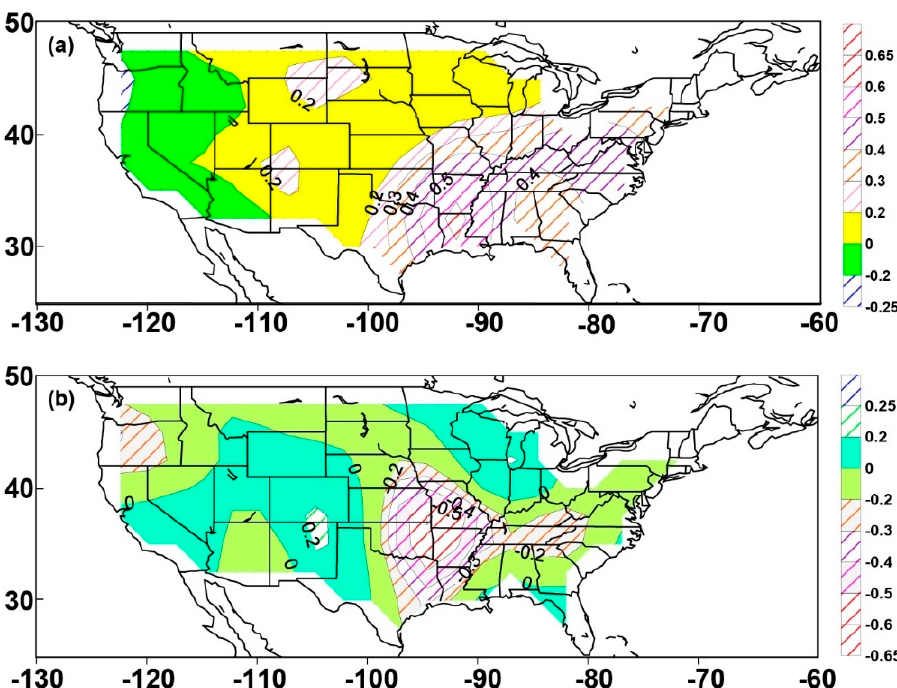
Figure 6. Spatial distribution of correlation coefficients ( a ) between (E)F1-(E)F5 tornado count (1954-2018) and meridional wind speed (m s − 1 ) and ( b ) between (E)F1-(E)F5 tornado count (1954-2018) and omega ( ω , Pa s − 1 ). The shaded areas indicate a statistically significant level of >95%.